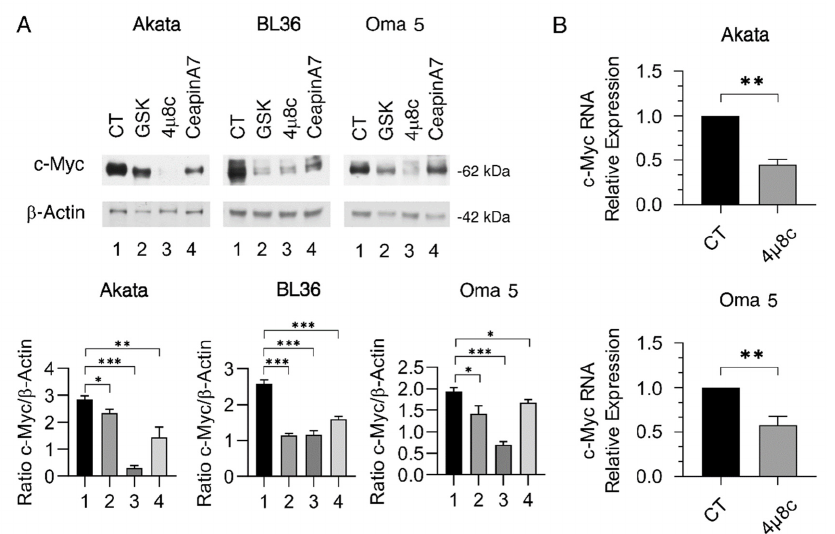
Figure 2. UPR sensor inhibitors affect c-Myc expression . Akata, BL36, and Oma 5 cells were treated with GSK2606414 (GSK) (0.5 µ M), 4 µ 8C (15 µ M), or CeapinA7 (12 µ M) for 24 h. The untreated cells were used as control (CT). ( A ) c-Myc expression was evaluated by Western blot analysis. β -Actin was used as loading control and one representative experiment is shown. The histograms represent the densitometric analysis of the ratio of c-Myc/ β -Actin of three different experiments. Data are represented as the mean plus S.D. ( B ) qRT-PCR of c-Myc in Akata and Oma 5 cells treated or not with 4 µ 8C (15 µ M) for 24 h. The data are expressed relative to reference gene B2M. The histograms represent the mRNA expression levels of c-Myc genes of three different experiments. The data are represented as the mean relative to the control plus S.D. p value: * p < 0.05; ** p < 0.001; *** p <